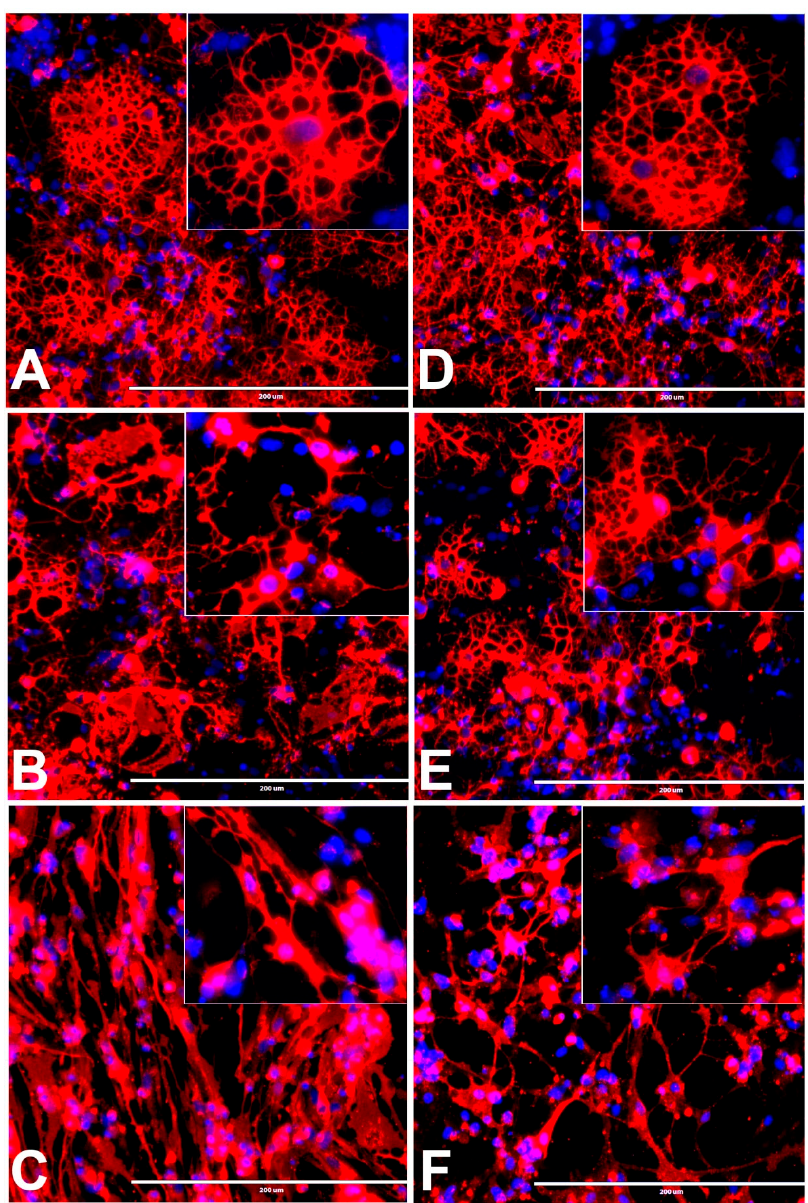
Figure 4. Effects of different doses of BPA or BPF on the morphological differentiation of rNSCs into oligodendrocytes. The rNSC cultured in oligodendrocyte directed differentiation media in the presence or absence of BPA or BPF for 7 days. Differentiated oligodendrocytes were visualized with oligodendrocyte-specific protein-marker mGalC and nuclei specific-marker DAPI. The images shown are representative fluorescent images of oligodendrocyte differentiation ( A ) in the absence of BPA (control), ( B ) in the presence of 50 µM BPA, ( C ) 100 µM BPA; ( D ) in the absence of BPF (control), ( E ) in the presence of 50 µM BPF, and ( F ) 100 µM BPF. Scale bar indicates 200 µm at 20× magnification.